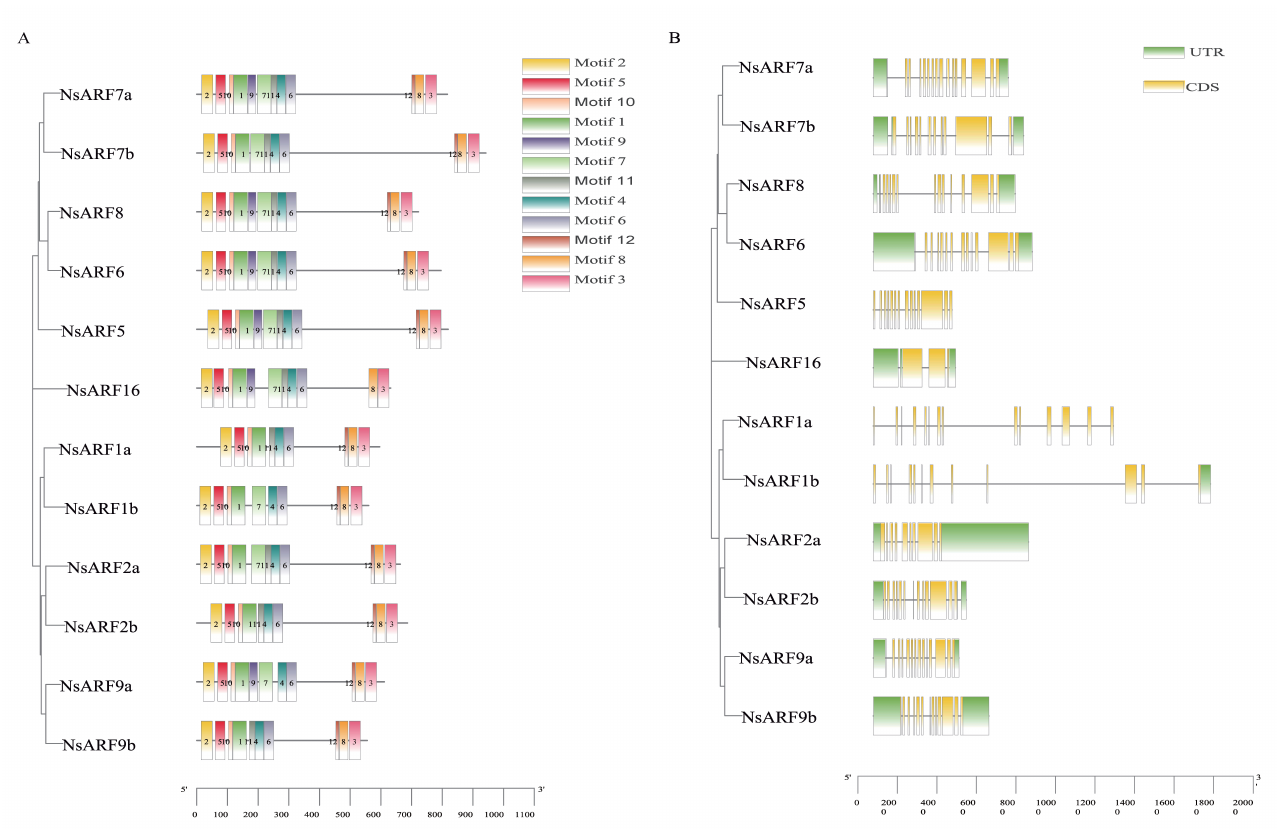
Figure 3. ( A ): Conservative motif distribution of NsARF genes. ( B ): Domain distribution of NsARF